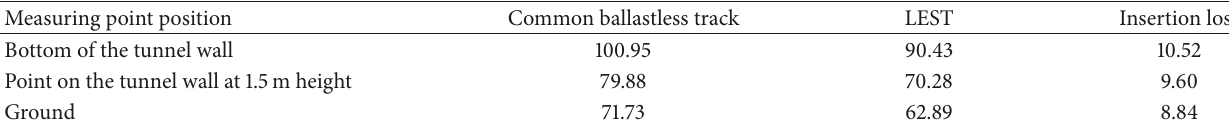
Table 3: Overall vibration levels of the tunnel wall and ground in straight track (1–200 Hz) (dB). Measuring point position Bottom of the tunnel wall Point on the tunnel wall at 1.5 m height